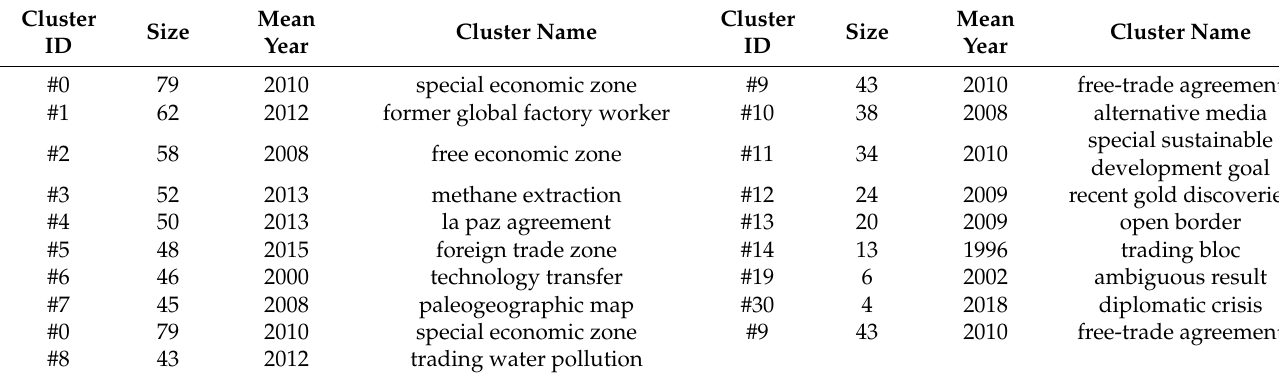
Table 5. Clusters that generalized the